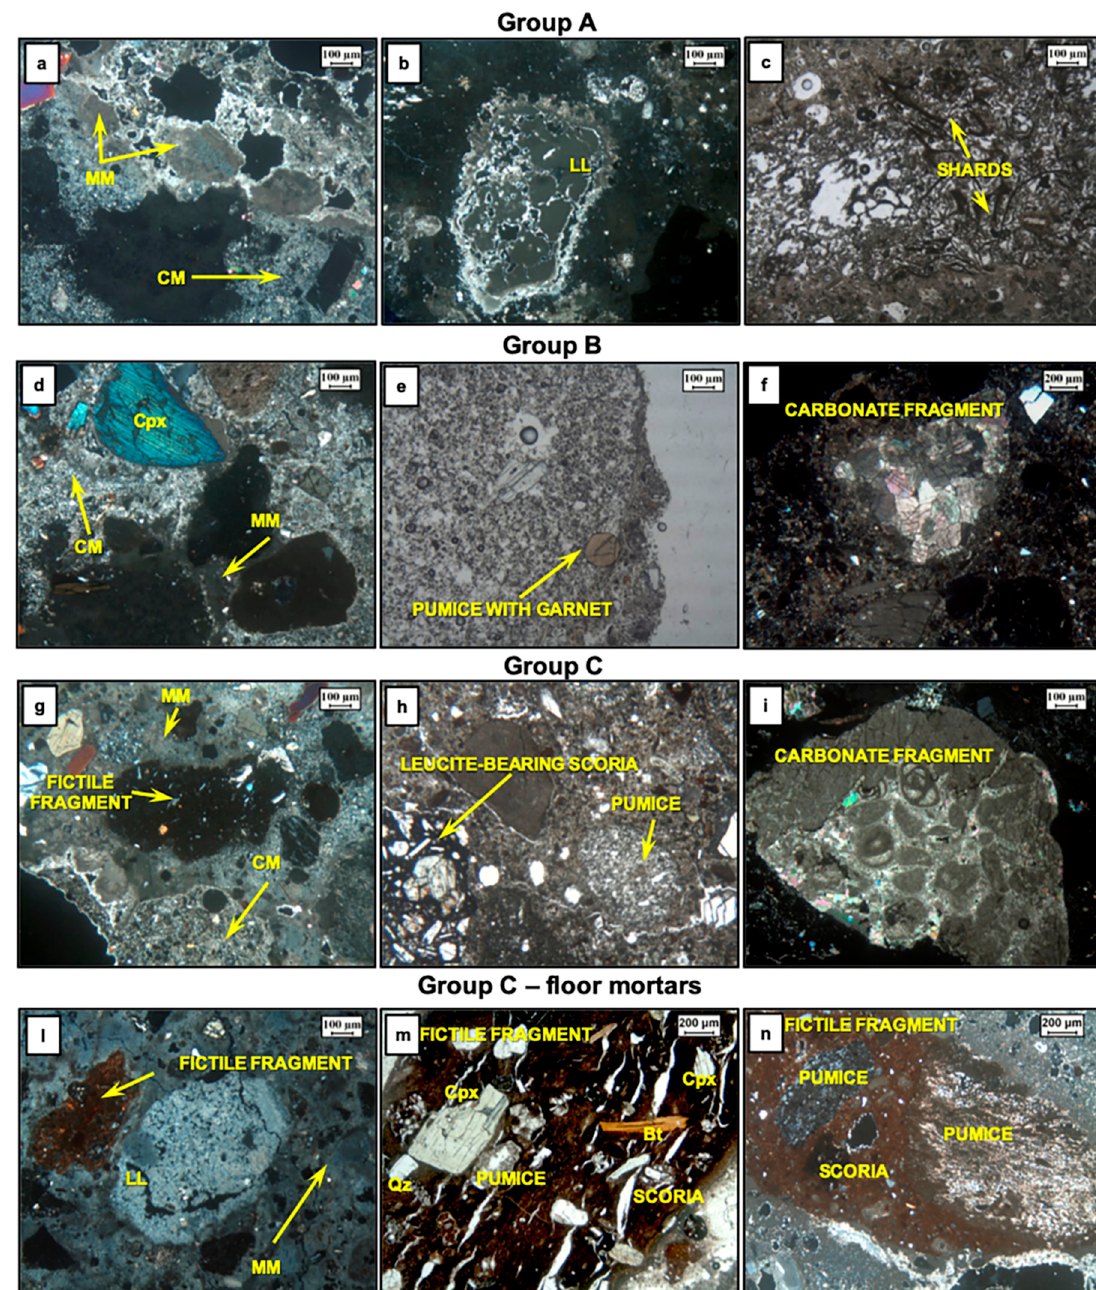
Figure 5. Microphotographs of mortar components (in CPL: Cross Polarized Light; PPL: Plane Polarized Light). Abbreviations: MM: micritic matrix; CM: Cryptocrystalline matrix; LL: lime lump; Cpx; clinopyroxene; Bt: biotite; Qz: quartz. Group A: ( a ) micritic matrix and cryptocrystalline matrix (CPL) in VP3 sample; ( b ) lime lump (CPL) in VP2 sample; ( c ) glassy shards in volcanic aggregates (PPL) in VP3 sample; group B: ( d ) micritic matrix, cryptocrystalline matrix and clinopyroxene (CPL) in VP8 sample; ( e ) pumice with garnet (PPL) in VP12 sample; ( f ) marble fragment (CPL) in VP7 sample; group C: ( g ) cryptocrystalline matrix, micritic matrix and fictile fragment (CPL) in VP15 sample; ( h ) leucite-bearing scoria and pumice (PPL) in VP17 sample; ( i ) carbonate rich sedimentary rock fragment (CPL) in VP18 sample; group C-floor mortars; ( l ) micritic matrix, lime lump and fictile fragment (CPL) in VP19 sample; ( m,n ) different types of fictile fragments (CPL) in VP20 sample.